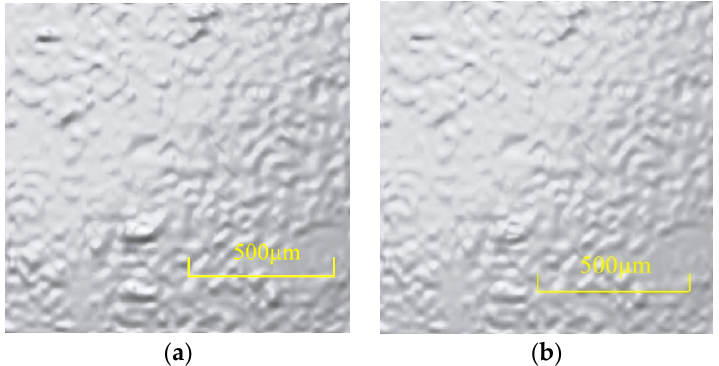
Figure 7. The surface topography under different contact pressures: ( a ) 0.02 MPa; ( b ) 0.16 MPa.